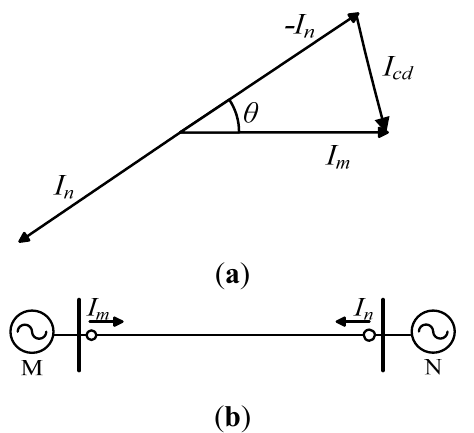
Figure 2. Current vector changes caused by inconsistent delay. ( a ) Vector diagram of currents; ( b ) current differential protection.